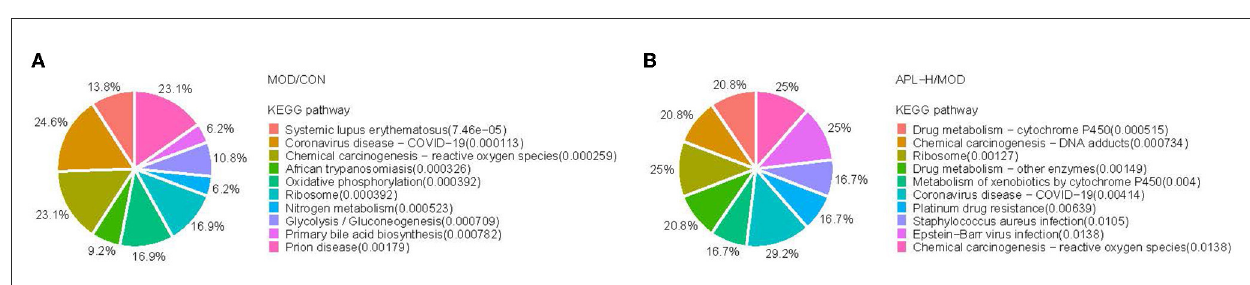
the functions of nucleotide repair system and cell